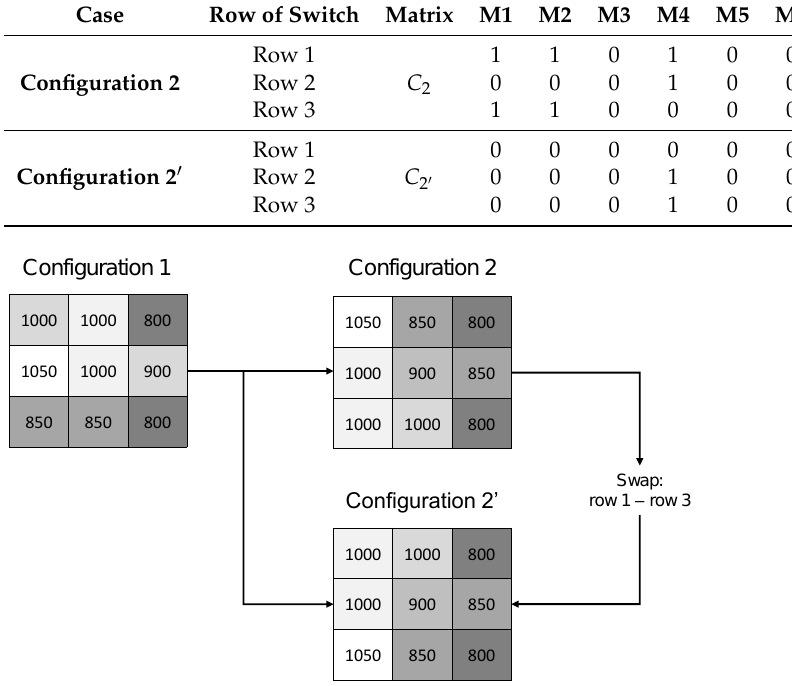
Figure 9. Example of two optimal configurations solved from an initial